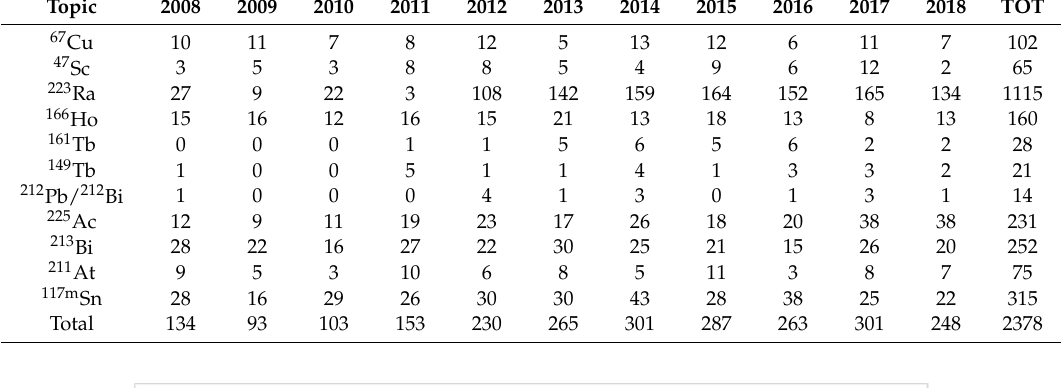
Molecules 2019 , 24 , x FOR PEER REVIEW Table 7. Annual publications discussing ERNs (2008–2018).